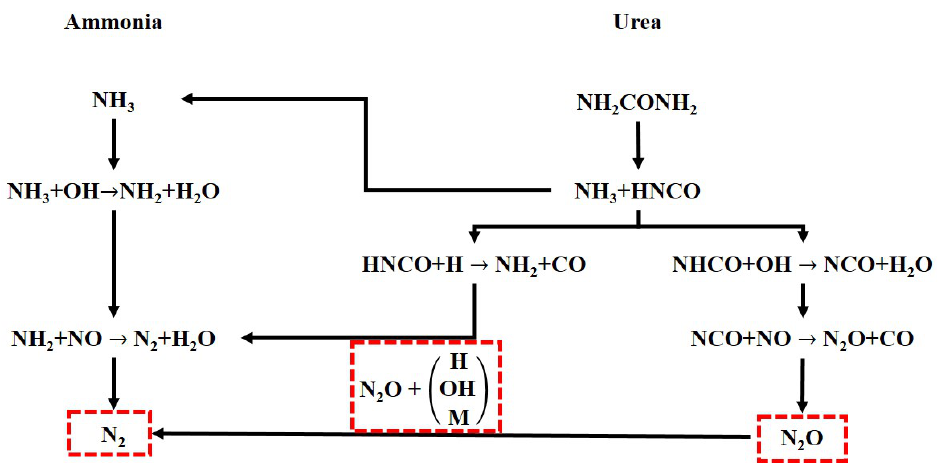
Figure 1. Basic decomposition mechanism of nitrous oxide using ammonia and urea aqueous solution reductants [13].